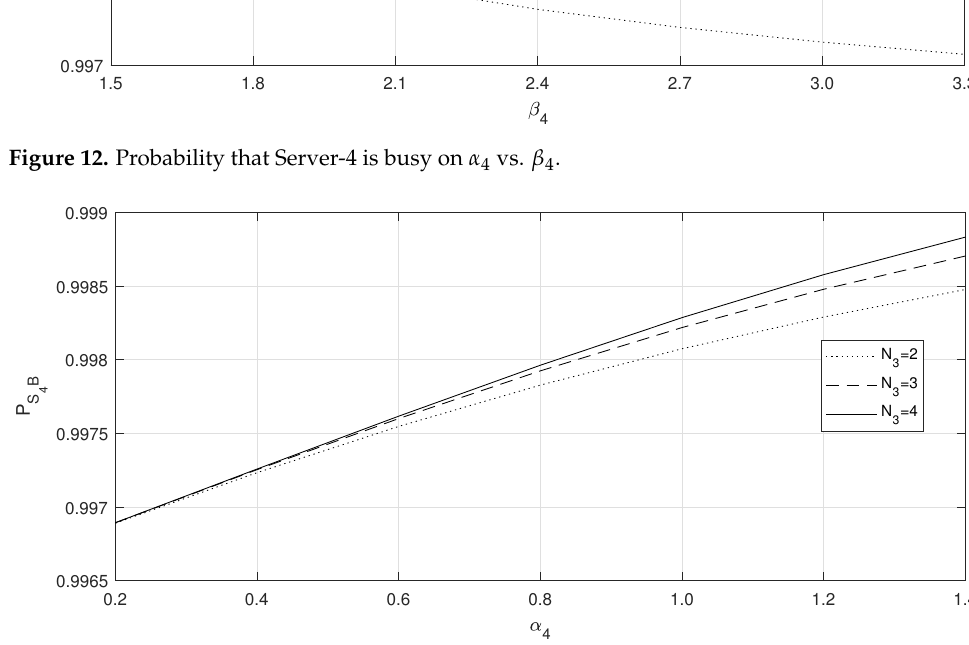
Figure 13. Probability that Server-4 is busy on α 4 vs. N 3